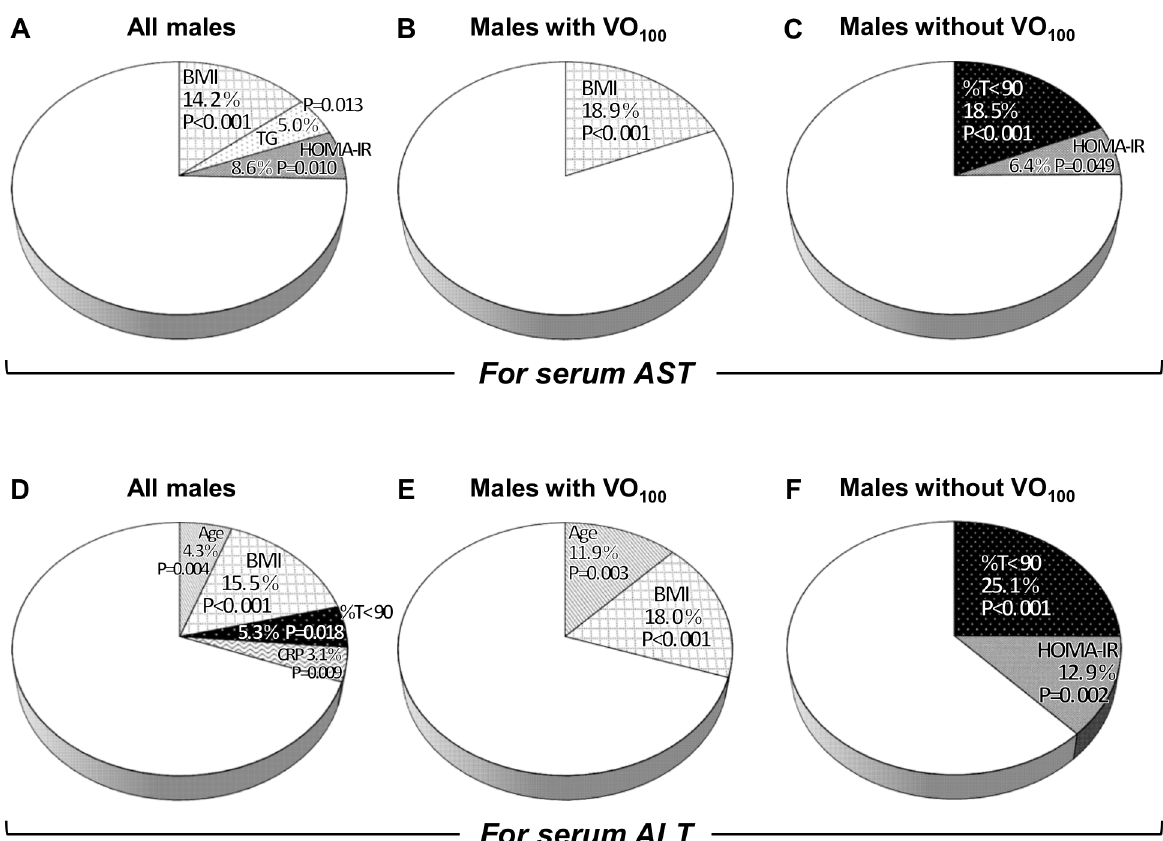
Fig 3. Coefficients of determination (R 2 ) in stepwise multiple regression models for serum transaminase values in all males and males stratified according to VO 100 . Serum AST and ALT values in all males (A, D), in males with VO 100 (B, E), and in males without VO 100 (C, F). Variables entered into the stepwise regression analyses were selected from age, BMI, neck circumference, waist circumference, systolic and diastolic blood pressures, alcohol intake, use of lipid-lowering agents, current smoking, VFA, SFA, AHI, 4%ODI, %T < 90, lowest SpO 2 , arousal index, REM sleep, AHI during REM, supine sleep time, AHI in supine position, Epworth sleepiness scale score, CRP, triglycerides (TG), HDL-cholesterol (HDL-C), LDL-cholesterol, fasting plasma glucose (FPG), and HOMA-IR when yielding a P-value < 0.10 by univariate